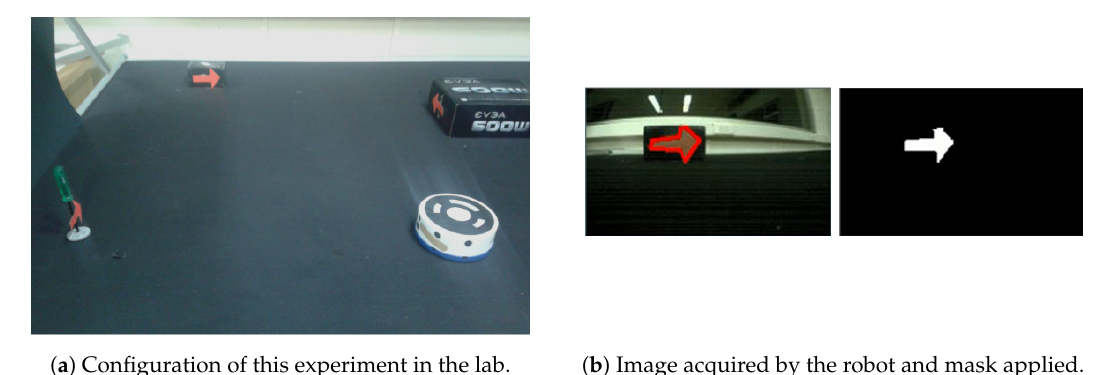
Figure 9. Detection of arrows of the same color in a real